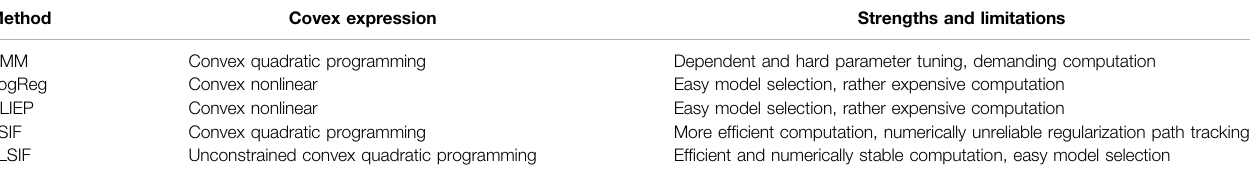
TABLE 1 | Indirect density estimation methods.